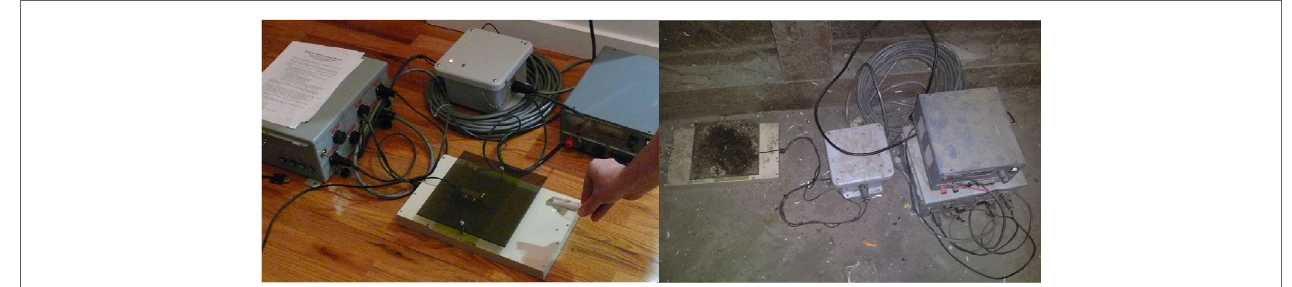
FIGUrE 2 | rFID system . Sensor, data logger, system control